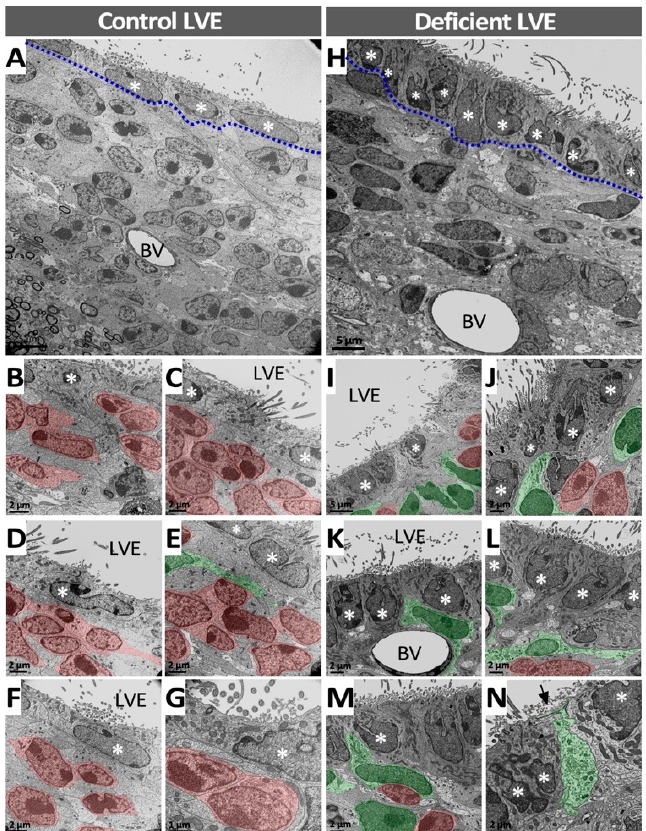
Figure 8. Ultrastructural analysis of the LVE of vitamin-C-deficient guinea pigs. ( A – G ) Ultrathin sections of the LVE of control guinea pigs; the ciliated ependymal cell line (dashed line) and a large number of cells in the subependymal area is identified ( A ). Neuroblasts (in red) and astrocytes (in green) exhibit a similar morphology to that described in the control SVZ; however, the ependymal cell nucleus (white asterisks) is more regular in the LVE ( B – G ) compared with the control SVZ. Most of the subependymal cells correspond to neuroblasts ( B – G ). ( H – N ) Ultrathin sections of the LVE of vitamin-C-deficient guinea pigs show that the cell distribution was similar to control LVE. However, the number of cells was dramatically decreased and the morphology of the ependymal cell nuclei (white asterisks) was significantly altered ( H – N ). Neuroblasts were reduced in number (cells in red), while the number of astrocytes (cells in green) increased ( I – N ). BV: blood vessel. LVE: lateral ven- tricle extension.